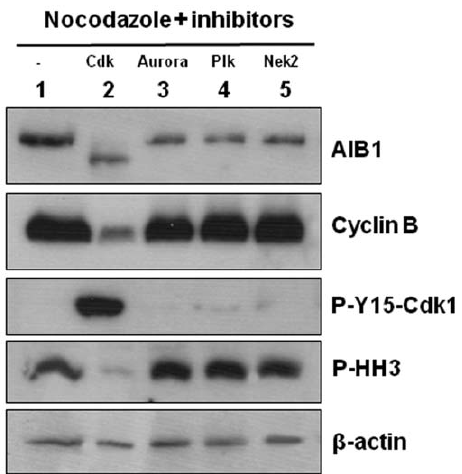
Figure 4. AIB1 is not a substrate of Aurora A, B, Plks or Nek2. Floating HeLa cells arrested at mitosis with nocodazole were further treated for three more hours with vehicle alone as control (lane 1), 10 m M purvalanol A (lane 2), 1.25 m M Aurora kinase inhibitor II (lane 3), 7 m M Plk inhibitor III (lane 4) or 100 m M of the Hec1/Nek2 inhibitor I (lane 5). Cells were lysed and analyzed by westernblotting against the indicated molecular species. Importantly, exposure of cells to the Cdk1 inhibitor caused the desphosphorylation of AIB1 together with a rapid mitotic exit (lane 2) to a similar extent as previously reported with other inhibitors [31,32]. On the other hand, exposure of mitotic cells to inhibitors specific for Aurora A, B, Plks or Nek2 did not show any significant effect on AIB1 phosphorylation, suggesting that neither of them is a kinase for AIB1 under the experimental conditions tested. The protein kinase inhibitor staurosporine causes morphological changes at mitosis in HeLa cells, including the decondensation of chromosomes and the reformation of nuclear membrane [33]. Treatment with the different kinase inhibitors at the concentrations indicated by the supplier caused similar morphological changes plus the reattachment of cells to the surface of the petri dish (data not shown), suggesting that the inhibitors indeed exerted a biologically relevant